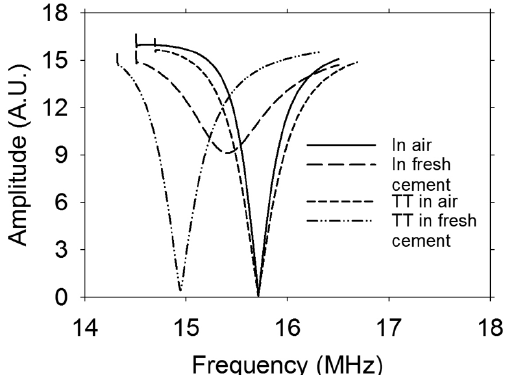
Figure 4. Fr equency response of the sensor outside and inside the fresh cement paste w/c ratio = 0.60. TT means sensor with Teflon tube.